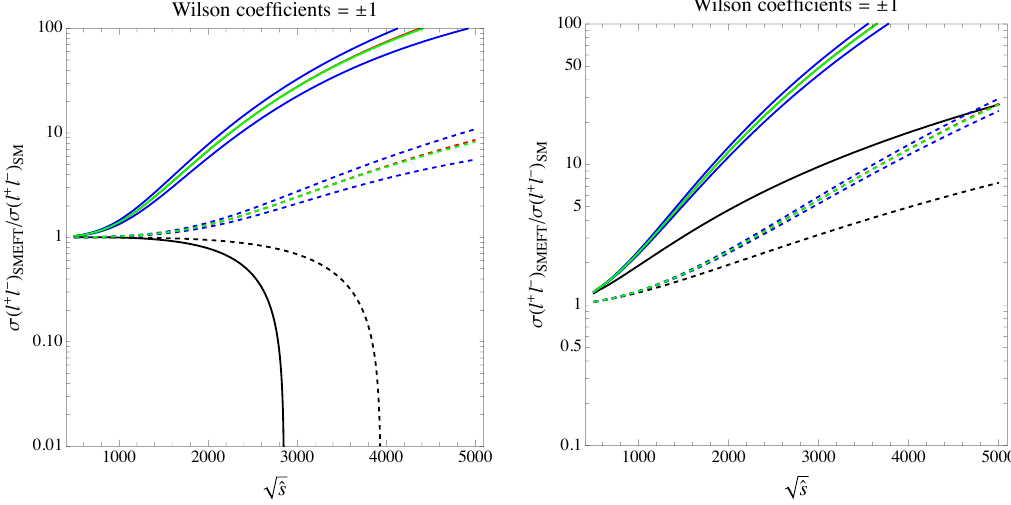
√ ˆ s at various SMEFT orders compared to the SM assuming all Wilson Figure 5 . dσ ( pp → ‘ + ‘ − ) /d coefficients have magnitude 1 . The black line shows the result including O (1 / Λ 2 ) SMEFT terms while the green and blue lines show the ratios including dimension six squared terms and the full O (1 / Λ 4 ) calculation, respectively. The two O (1 / Λ 4 ) curves differ in the assumptions made about the sign of the dimension eight pieces; in the upper curve, we chose signs to maximize eq. (B.8) (as much as possible, choosing to maximize up quark initial states over down quark), while in the lower curve we minimize eq. (B.8). The curve with all dimension eight coefficients chosen positive is nearly identical to the green line, as it is subject to cancellations. For the solid lines, the new physics scale Λ = 5 TeV, while dashed lines have Λ = 10 TeV. The difference between the left and right panels is the sign choices for the dimension six contact terms. In the left panel, all coefficients are taken as +1 , which causes cancellations within some helicity pieces and results in a net destructive interference with the SM. In the right panel, the signs have been chosen to make the interference (at least for up quark initial states) positive